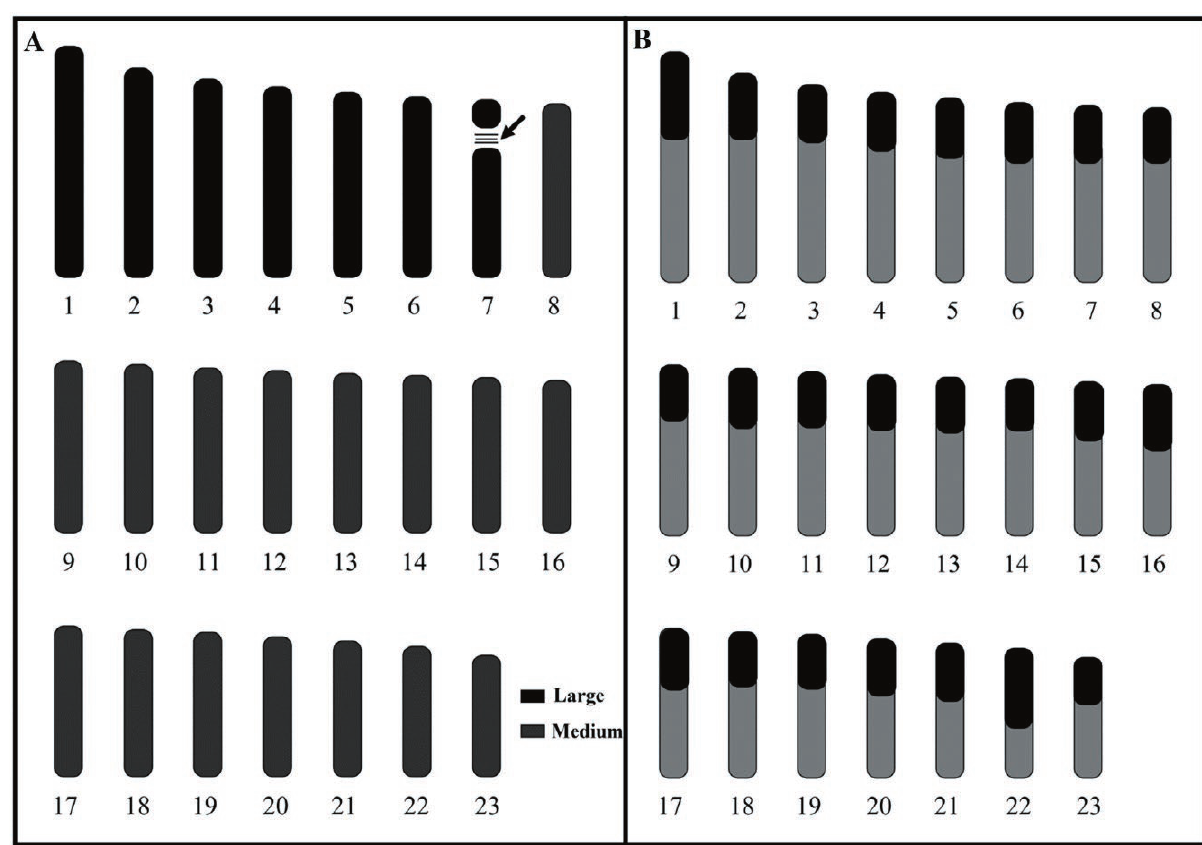
Figure 4. Idiograms showing shape and length of chromosome of Moonlight Gourami, Trichopodus microlepis (Perciformes, Osphronemi- dae) represented the haploid set ( n =23) by conventional staining (A) and C-banding (B). Arrow indicates secondary constriction/NOR on the long arm of the telocentric chromosome pair